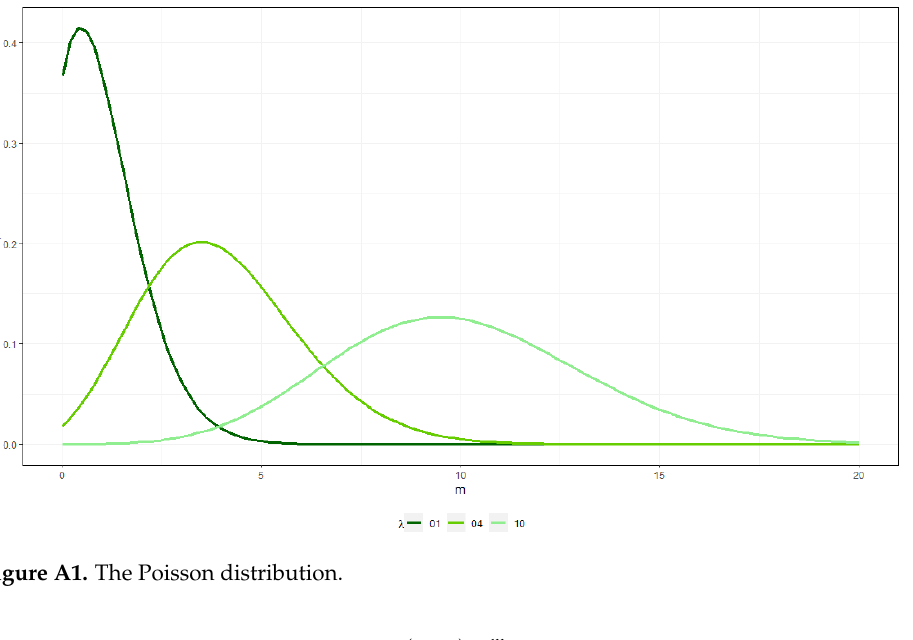
Figure A1. The Poisson